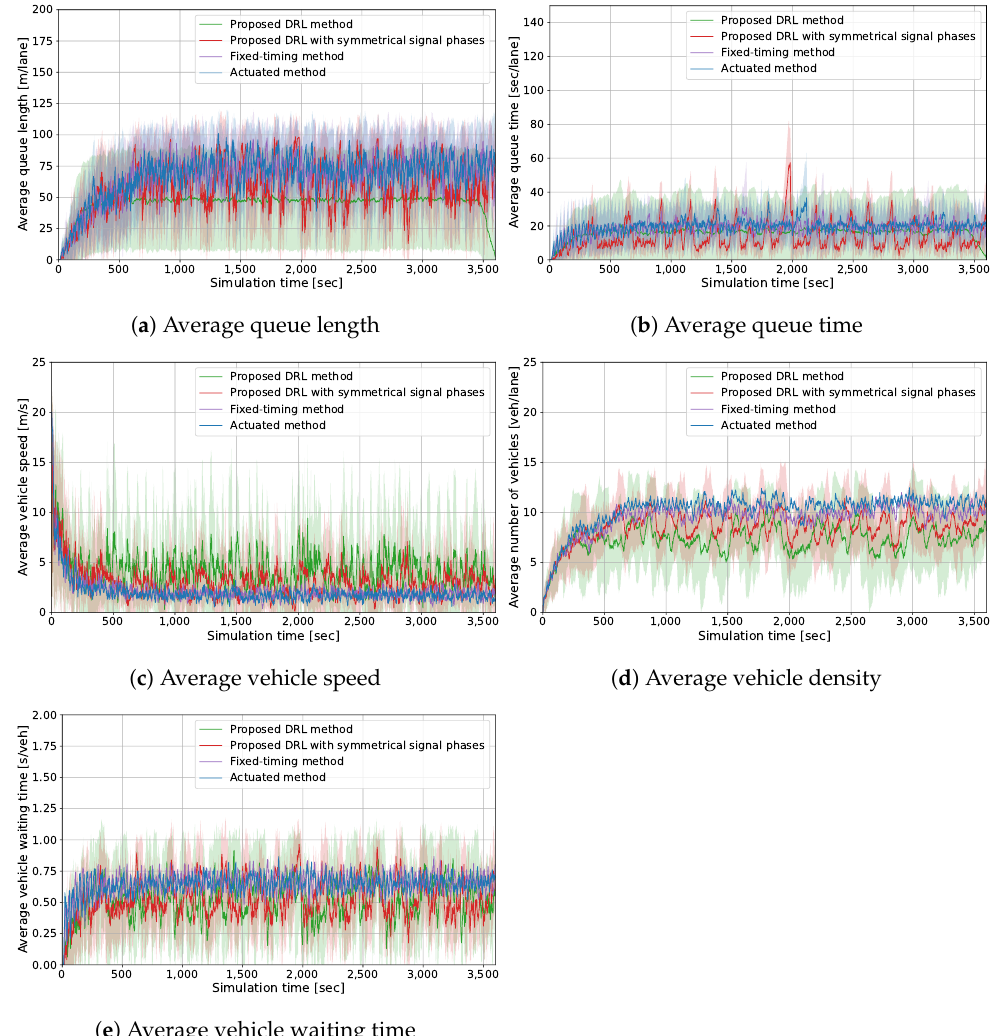
Figure 15. Simulation comparisons with the DRL-based controller trained using symmetric